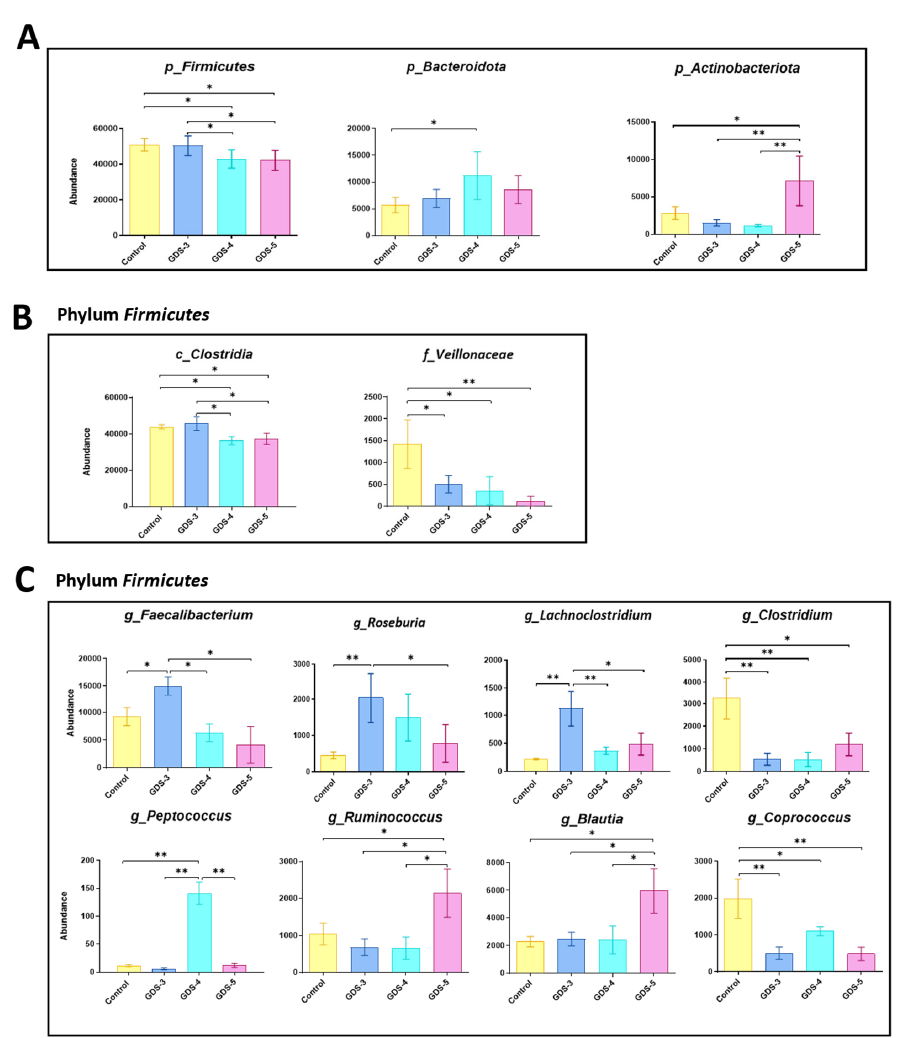
Figure 8. Gut microbiota in the Alzheimer’s disease (AD) patients and the control subjects. The relative abundance of the bacterial taxa in the feces from the control subjects and the AD patients classified in the stages GDS-3, GDS-4 and GDS-5. The data are the means ± the SEM; (n = 10, control subjects; n = 12, AD patients; 4 per stage). ( A ) The bacterial phylum. ( B ) The bacterial class and the family belonging to the Firmicutes phylum. ( C ) The genera belonging to the Firmicutes phylum. The ANOVA shows an effect ( p < 0.05) between AD classified in the stages and the bacterial taxa. Tukey’s test: * p < 0.05 and ** p < 0.01. p, phylum; c, class; f, family; g, genus. Within the phylum Bacteroidota , compared to the control and the GDS-3 AD patients, the class Bacteroidia and the genus Barnesiella were more abundant in the GDS-4 patients and the family Bacteroidacea and the genera Bacteroides and Alistipes increased in the GDS- 4 and GDS-5 patients (Figure 9A). Regarding the phylum Actinobacteriota , compared to all the other groups, we observed an increase in the abundance of the class Actinobacteria in the GDS-5 patients but a reduction in the family Bifidobacteria and the genus Bifidobacte- rium at GDS-3 and GDS-4 (Figure 9B). In addition, within the phylum Verrucomicrobiota , the family Akkermansiaceae , the genus Akkermansia and the specie Akkermansia muciniphila were more abundant in the GDS-3 AD patients compared to the other groups (Figure 9C).